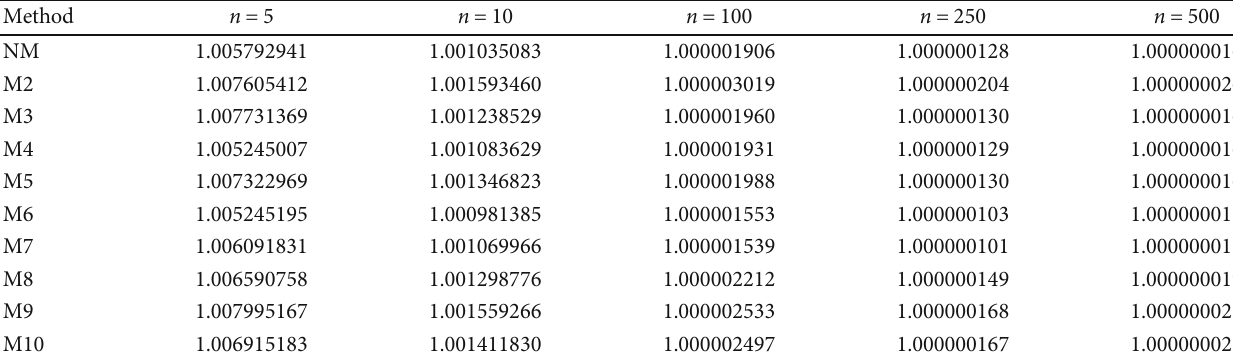
Table 23: The values of CEI for the methods in the fi rst category to solve Test Problem 1, with n = 5,10,100,250,500 .